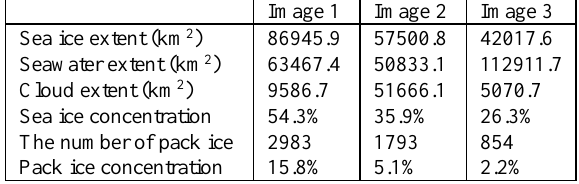
images recorded on June 10, July 14 and August 18, 2014.